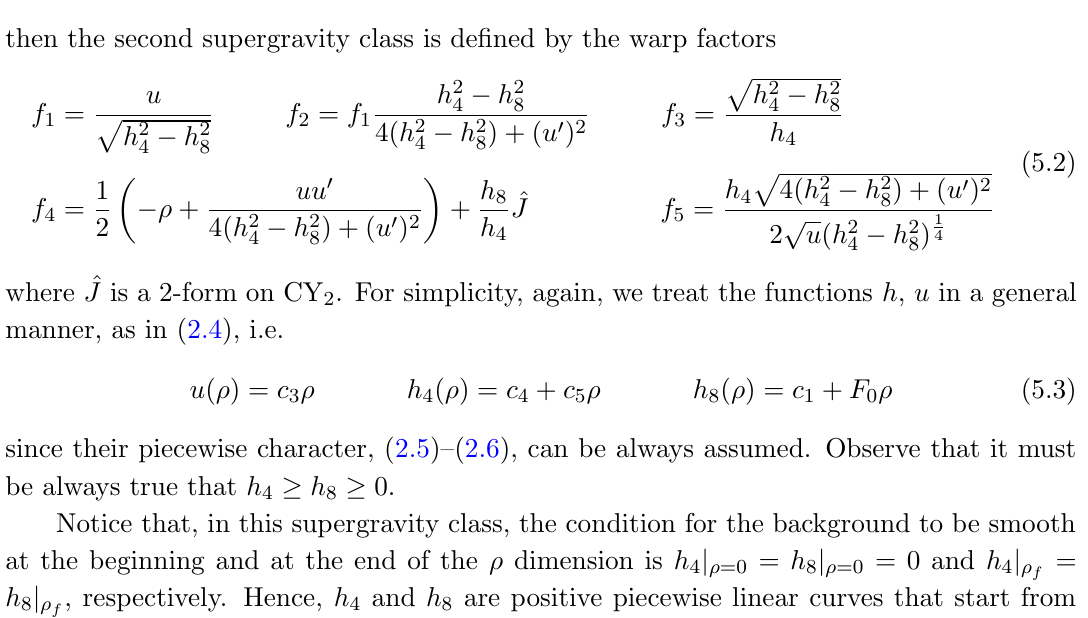
Figure 3 . An example of the linear functions h 4 ; 8 ( (cid:26) ) in Class II supergravity. These piecewise functions start from h 4 j (cid:26) =0 = h 8 j (cid:26) =0 = 0, with h 4 > h 8 always, and decrease in slope until they reunite at the end, (cid:26) f = 10 (cid:25)